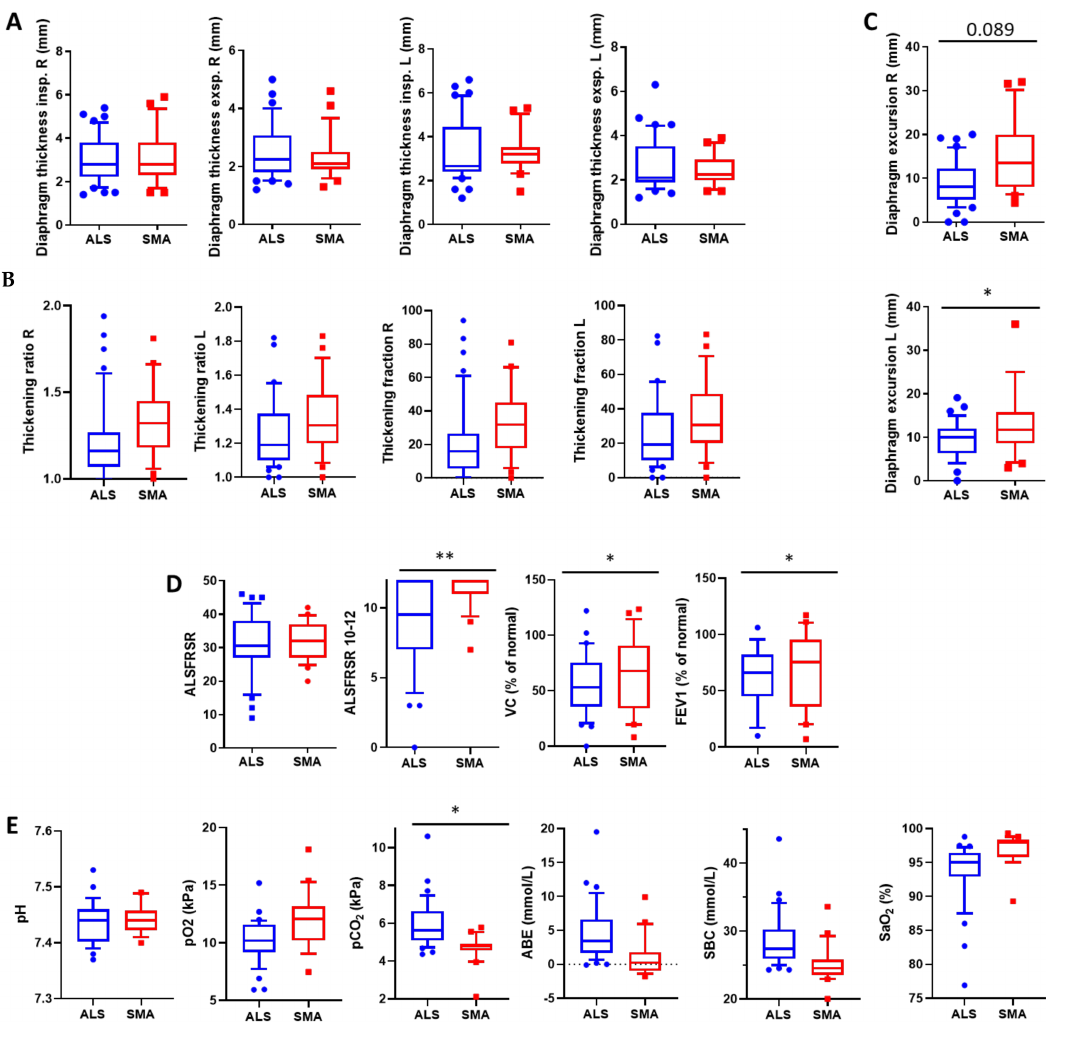
Figure 2. ( A , B ) Two-dimensional real-time mode with the end-inspiratory/-expiratory thickness of the diaphragm. Sonographic window: mid axillary line at the level of the diaphragmatic apposition zone. Measurement points: diaphragmatic and peritoneal pleural lines. Depicted are diaphragm thickness ( A ) and thickness ratio and fraction ( B ) in B mode, respectively. ( C ) Diaphragm excursion in M mode during breathing in a supine position at rest. ( D ) shows clinical and classical volatile res- piratory measures, ( E ) daytime blood gas analysis results. Abbreviations: ALSFRSR: ALS functional rating scale revised; VC (%), vital capacity (in percent of normal value); FEV1 (%), the first second of expiration (in percent of normal value). Normative values of spirometry were calculated according to Cri é e and colleagues [15], ABE, actual base excess; SBC, standard base concentration. Shown are box blots with IQR, the whiskers set at 10–90% percentiles. Multivariate linear regression (for continuous outcome variables) analyses were performed to adjust for the candidate covariates sex, age, and BMI. * indicates p values < 0.05; ** p values < 0.01. Table 2. Differences of diaphragm ultrasound imaging between the ALS and SMA subcohorts. Parameter Outcome ALS ( n = 40) SMA ( n = 23) p -Value § Diaphragm thickness median (IQR) insp. right Diaphragm thickness median insp. left